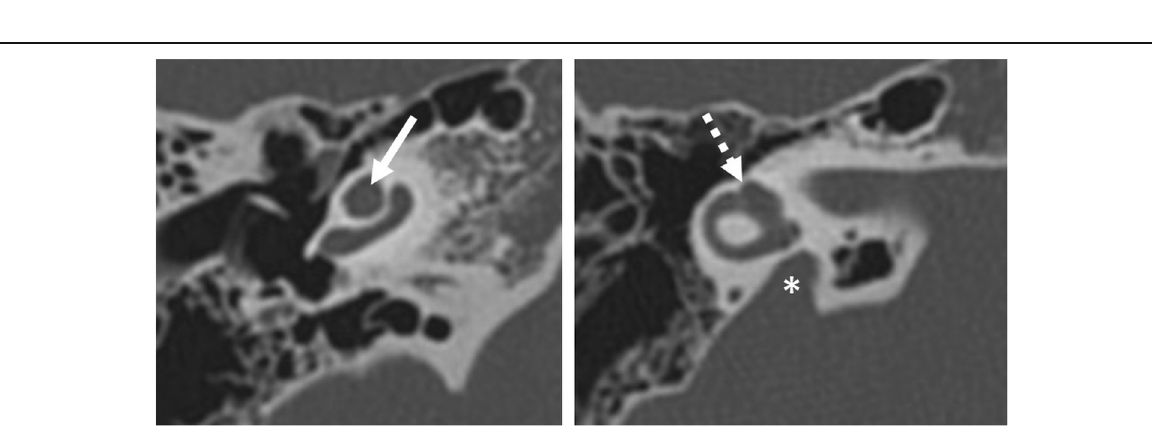
Fig. 9 A 12-year-old male patient, with bilateral severe SNLH from birth. HRCT axial images show incomplete partition type II with the cystic apex of the cochlea (arrow) and enlarged vestibular aqueduct (asterisk). Vestibulum is minimally enlarged (dashed arrow), and semicircular canals appear normal